Question: In a single sentence, describe what this figure presents.
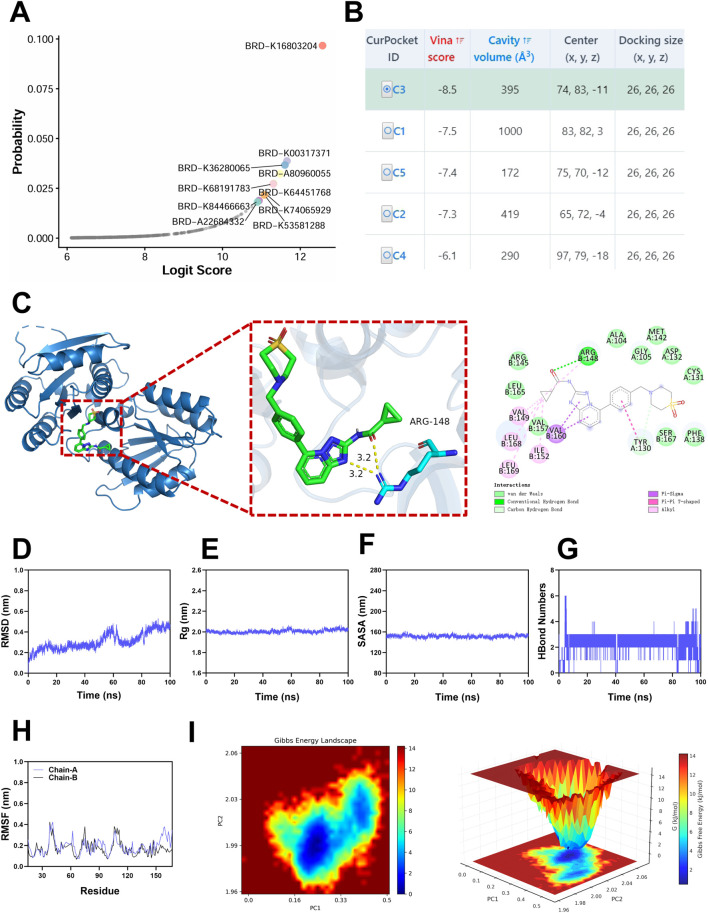
Answer: Drug repositioning, molecular docking, and molecular dynamics simulation of CENPM (A) DrugReflector screening identifies filgotinib as the top candidate (B) Docking poses in pockets C1–C5; optimal binding in C3 (Vina score = −8.5 kcal/mol) (C) Interaction diagram of filgotinib in pocket C3 (D–I) MD simulation analyses (D) RMSD, (E) Rg (F) SASA, (G) H-bond count (H) RMSF, and (I) free energy landscape.